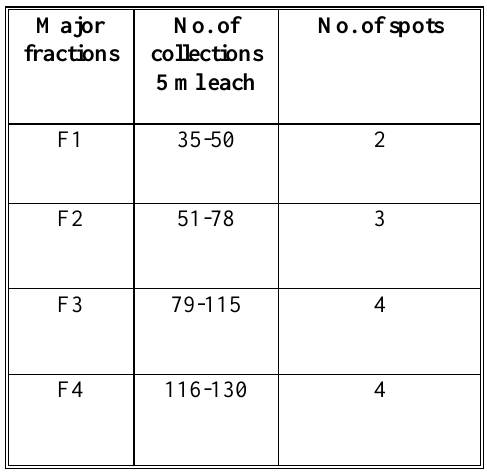
Table (2): Major fractions obtained from column chromatography